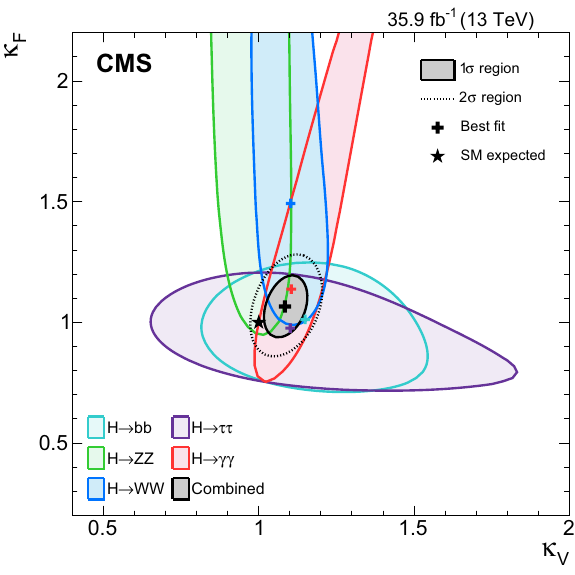
Fig. 17 The 1 σ and 2 σ CL regions in the κ F vs. κ V parameter space for the model assuming a common scaling of all the vector boson and fermion couplings